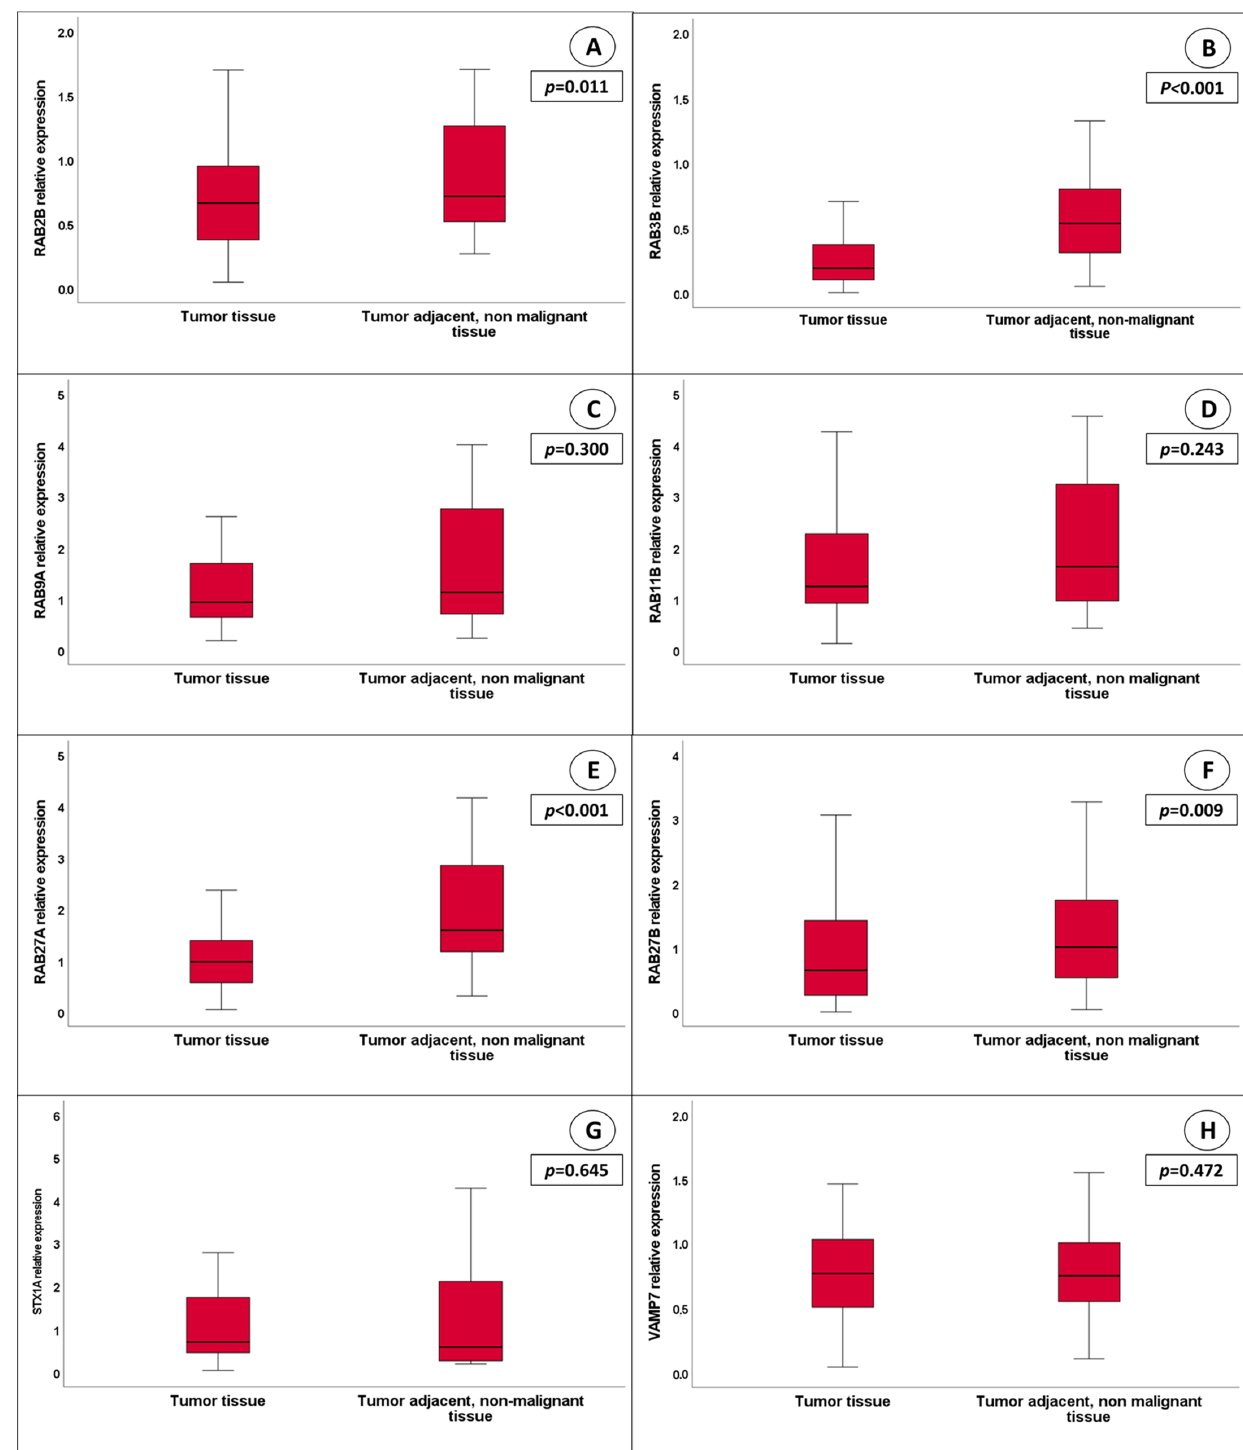
Figure 1. Relative gene expression between tumor (n = 109) and tumor-adjacent (n = 60) tissues of RAB2B ( A ), RAB3B ( B ), RAB9A ( C ), RAB11B ( D ), RAB27A ( E ), RAB27B ( F ), STX1A ( G ) and VAMP7 ( H ) in our CRC patients’ cohort. Gene expression of RAB2B , RAB3B , RAB27A, and RAB27B is lower in tumor tissues compared to tumor adjacent, non-malignant tissues, while for the other genes no statistically significant differences are